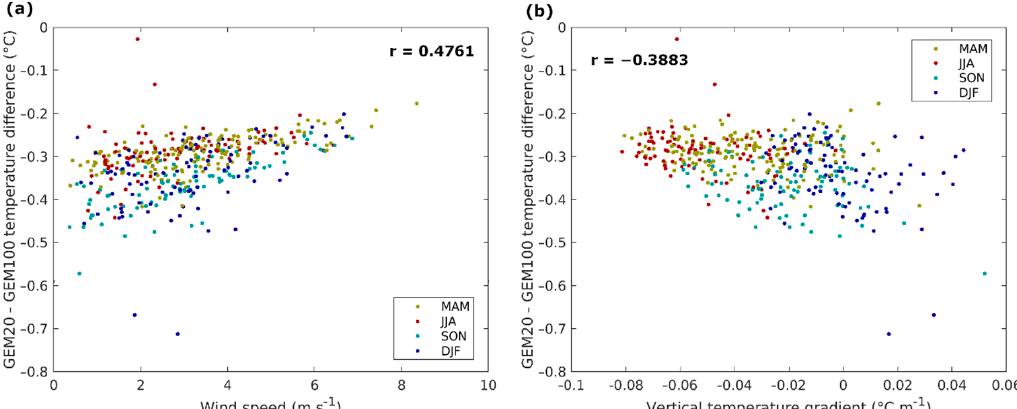
Figure 7. ( a ) Relationship between wind speed at 5 p.m. local time and GEM20-GEM100 2 m temperature difference at the same time, averaged over locations where the anthropogenic sensible heat flux due to traffic exceeds 10 W m − 2 . ( b ) Relationship between near-surface vertical temperature gradient at 4 p.m. local time and GEM20-GEM100 2 m temperature difference at 5 p.m. for the same locations. Different marker colors are used for different seasons: spring (MAM)—green; summer (JJA)—red; autumn (SON)—light blue; winter (DJF)—dark blue.